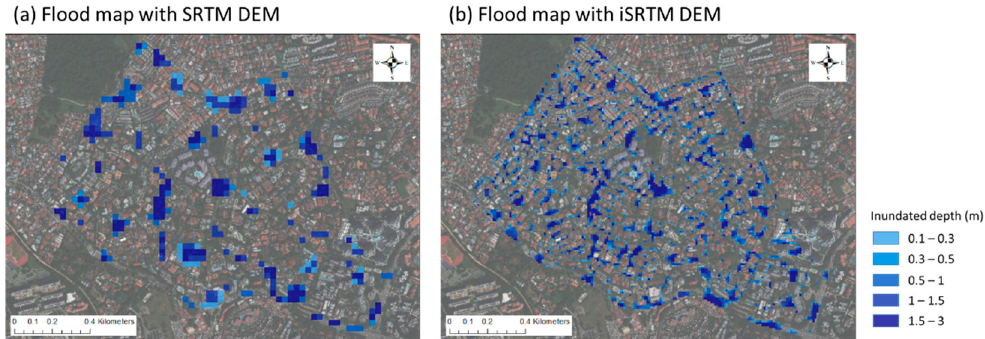
Figure 10. Flood map comparisons between ( a ) Flood map with SRTM DEM and ( b ) Flood map with iSRTM DEM in dense urban area of Singapore.